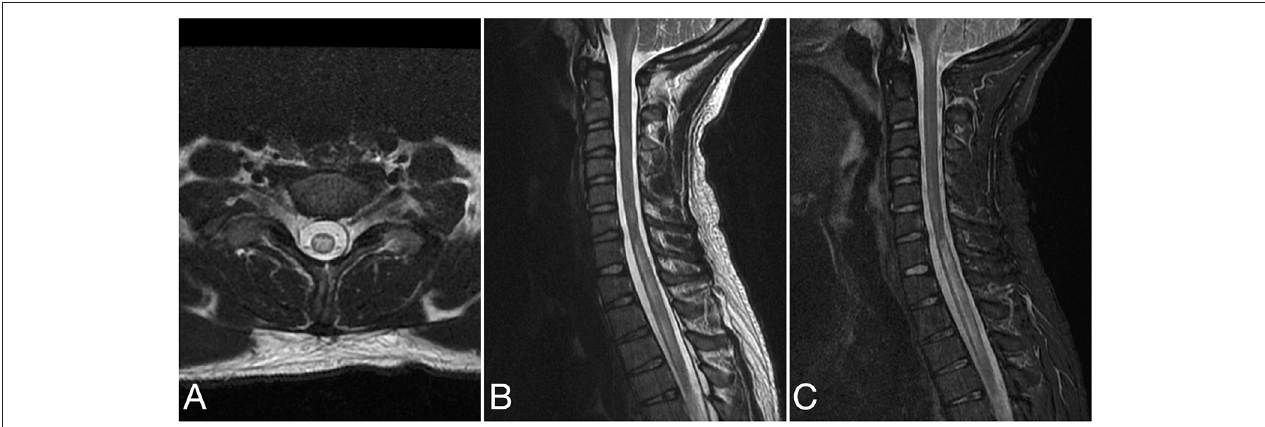
FIGURE 4 | Axial T2 (A) , sagittal T2 (B) , and sagittal STIR (C) images of the cervical spine from the same patient at the time of disease presentation. A longitudinally extensive T2/STIR hyperintense lesion ( ≥ 3 contiguous vertebral segments) involve the spinal cord at the cervicothoracic junction.